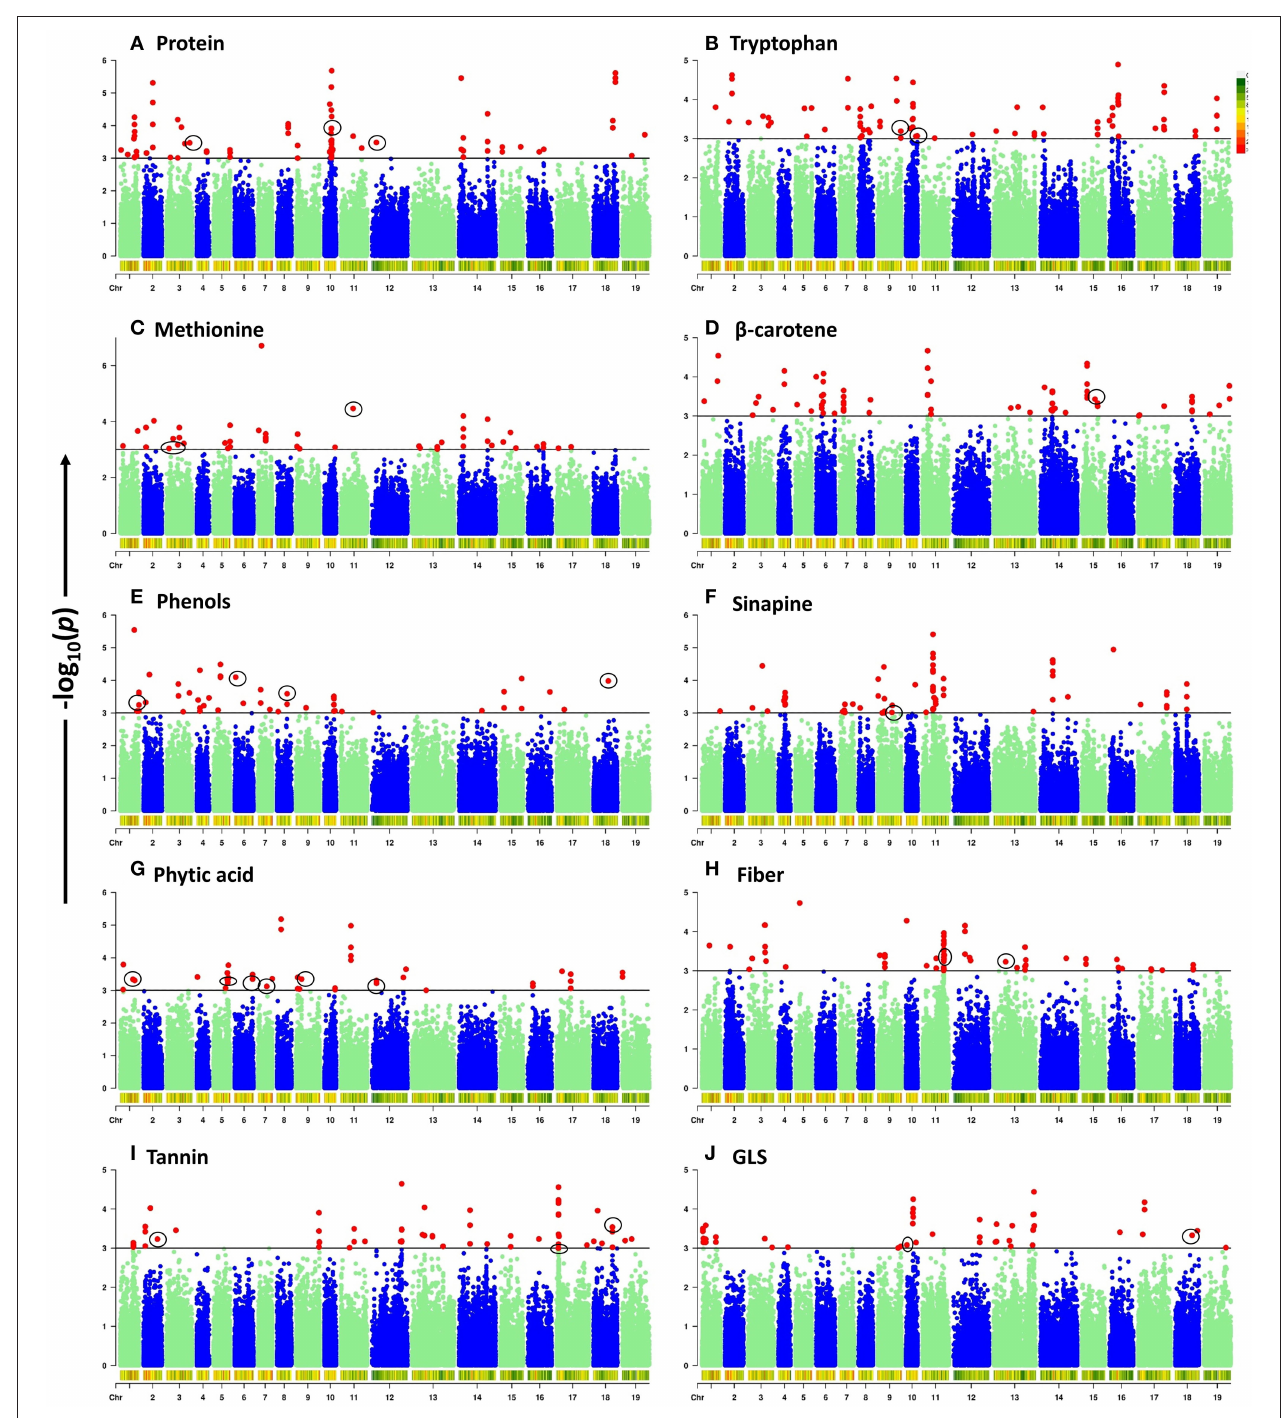
FIGURE 2 | Manhattan plots of genome-wide association analysis for ten seed meal quality traits. -log 10 ( p ) values are plotted against position on each chromosome. Black lines at -log 10 ( p ) = 3 indicate the genome-wide significance threshold. SNPs with -log 10 ( p ) ≥ 3 were considered as significant. Chromosomes 1–10 represent A genome mentioned as A01–A10 and chromosomes 11–19 represent C genome mentioned as C01–C09 in manuscript. (A) Protein. (B) Tryptophan. (C) Methionine. (D) β -carotene. (E) Phenols. (F) Sinapine. (G) Phytic acid. (H) Fiber. (I) Tannin. (J) GLS. tryptophan biosynthesis (Chiba et al., 2012). HEMA2 encoding of tryptophan biosynthetic pathway (Muñoz-Nortes et al., 2017), PGM encoding for phosphoglycerate mutase family protein is a for glutamyl-tRNA reductase family protein which was located part of serine biosynthetic pathway, and serine is required for on chromosome A09 also has involvement in tryptophan